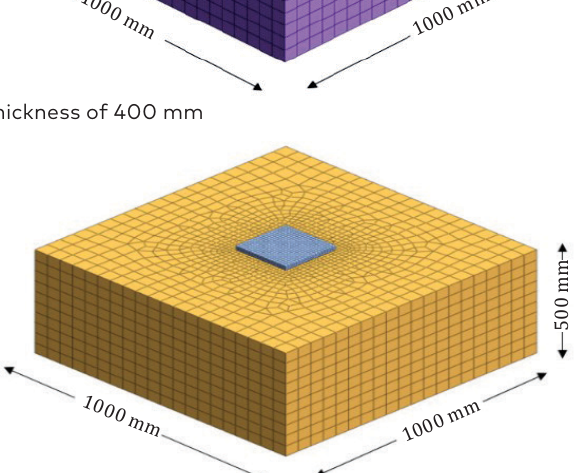
Figure 6. Numerical model representing subgrade